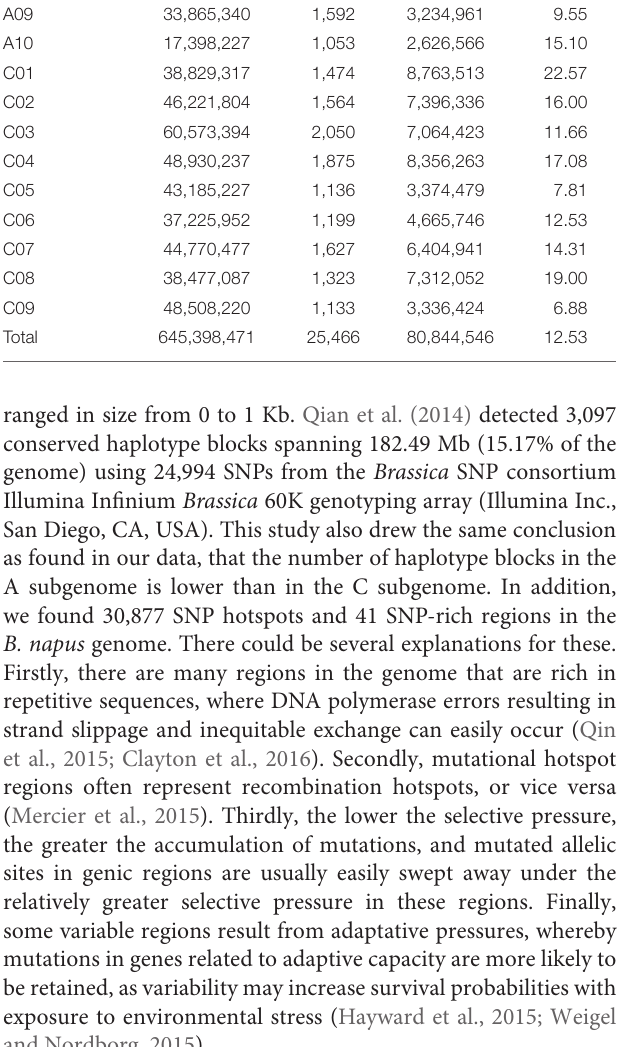
Block Block length number